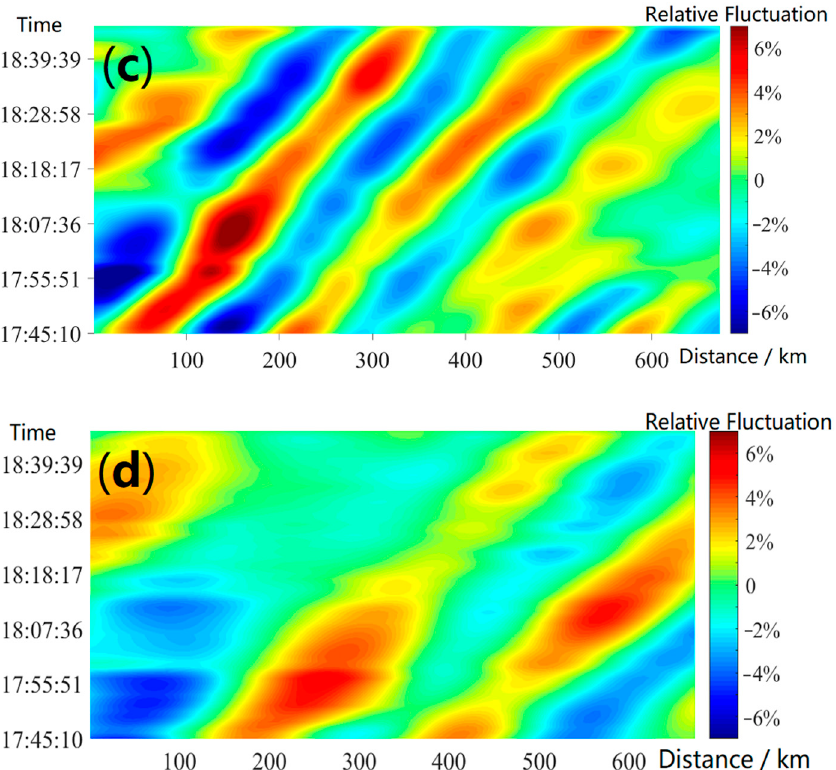
Figure 8. Relative intensity change within one hour. ( a – d ) Measured along the measuring line in the layer of n = 5, 6, 7, 8, respectively. The horizontal axes denote the distance (in kilometer) from the starting point of the measuring line. The left vertical axes are the time (UTC). The right color bar indicates the relative fluctuation defined by Equation (12).